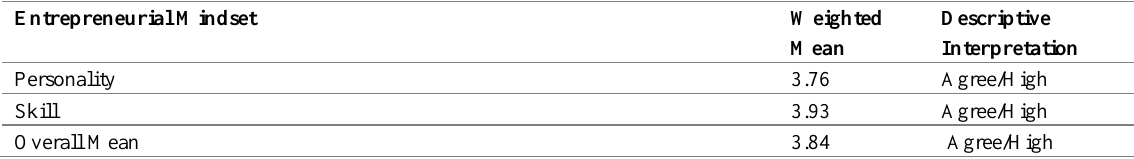
Table 3: Summary Table: Entrepreneurial